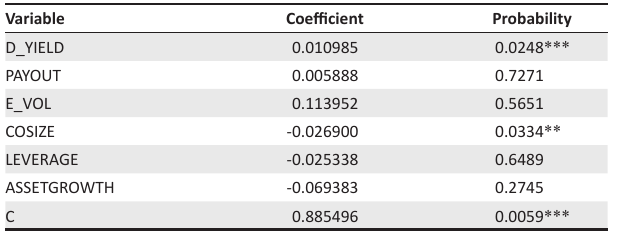
TABLE 4: Fixed effects model.